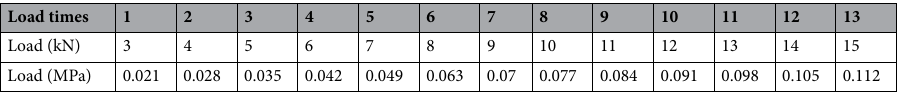
Table 1. Loading scheme.